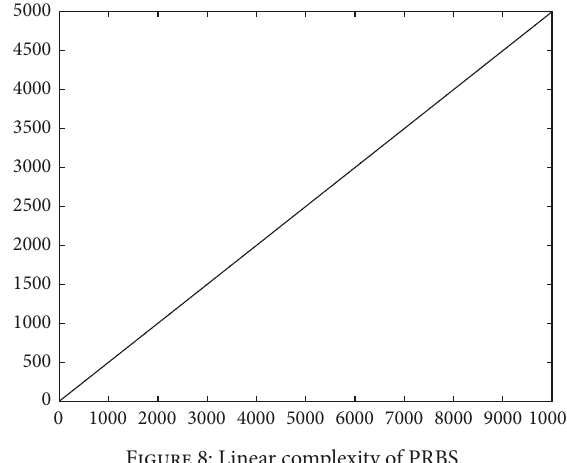
Figure 8: Linear complexity of